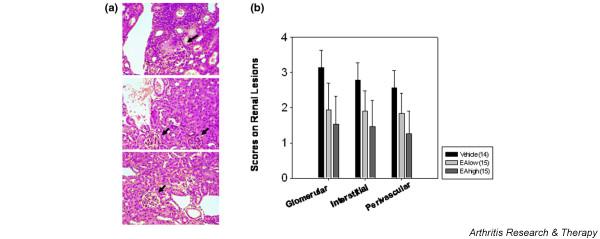
Changes in renal pathology as a result of treatment with the ethyl acetate (EA) extract of Tripterygium wilfordii Hook F. (a) Kidney from the vehicle group showed glomerulonephritis, tubular dilation and atrophy, and heavy cell infiltration in perivascular and interstitial region. Kidney sections from the mice of the (b) EAlow and (c) EAhigh groups showed normal glomeruli and tubules. Slight cell infiltration in perivascular regions was seen in (b). Results shown are representative of 14 animals of each group. Arrows indicate representative glomeruli. (d) Glomerular, interstitial and perivascular disease was scored from (0) to (4+) as described in Materials and methods. Numbers of mice examined are indicated in parentheses. *p < 0.05, **p < 0.01, ***p < 0.001, EAlow or EAhigh versus vehicle. Original magnification × 400.